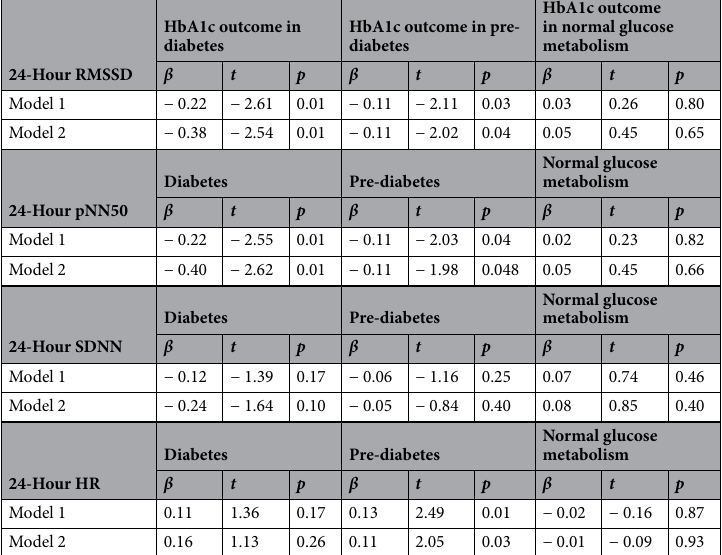
Table 3. Multivariate linear regression models showing the associations between glycated hemoglobin (HbA1c) and variables of heart rate and heart rate variability in people with normal glucose metabolism, pre-diabetes, and type 2 diabetes. Results are presented as standardized regression coefficient β representing standard deviation (SD) change of HRV or HR for 1 SD change in HgbA1c (1 SD is equivalent to 0.4% HbA1c among NGM, 0.2% HbA1c among pre-diabetes, and 1.3% HbA1c among T2DM). Model 1: Adjusted for age, sex, body mass index (BMI), and smoking. Model 2: Further adjustment for homeostatic model assessment for insulin resistance (HOMA-IR), fasting plasma glucose, high-sensitive C-reactive protein (hs-CRP), and Interleukin-18 (IL-18). Logarithmic value of RMSSD, IL-18, and hs-CRP is used, as these are not normally distributed. 24-Hour HR is derived from 24-h MEAN NN (60.000/MEAN NN = average 24-h HR in beats/min).